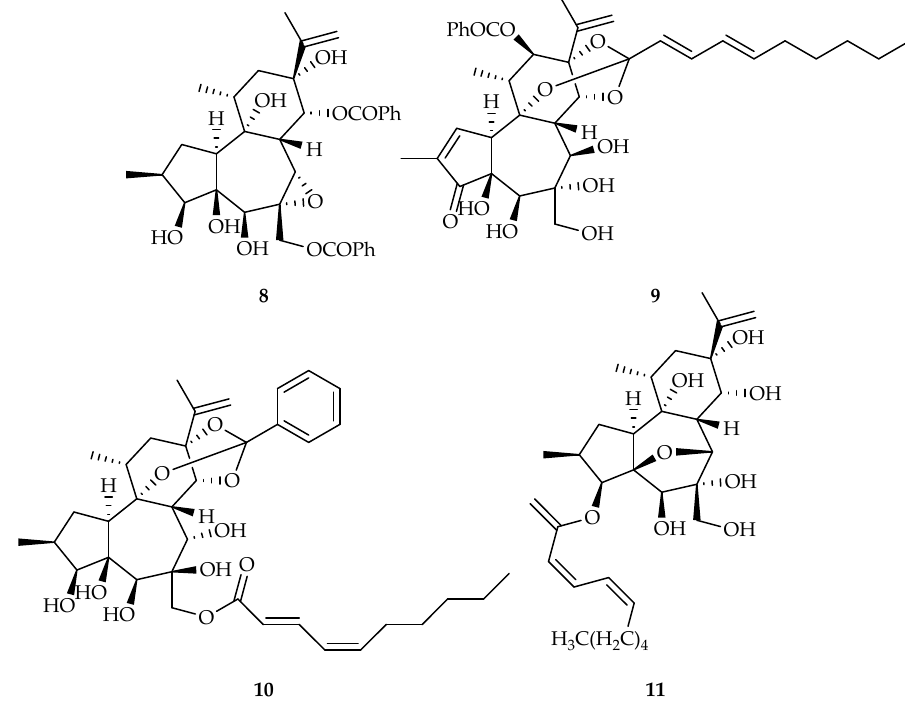
Figure 5. Structures of yuanhuakines A–D 8 – 11 [11]. A new daphnane with cytotoxic activity was isolated from the air-dried root of Euphorbia fischeriana Steud. By ethanolic extraction and subsequent partitioning with petroleum ether, CH 2 Cl 2 , EtOAc, and n -BuOH [12]. The new compound, named Langduin A 6 12 , showed IC 50 value of 13.42 μM against HepG2 (human hepatocellular liver carcinoma), using the CCK-8 assay and oxaliplatin as a positive control (Figure 6). From the dry roots of Euphorbia fischeriana Steud were also isolated two new daph- nane-type diterpenoids fischerianin A 13 and fischerianin B 14 [13]. Their structures, in- cluding the absolute stereochemistry, were determined by HRESIMS, IR, 1D and 2D NMR, as well as by comparing their experimental and calculated CD spectra. Compounds 13 and 14 harbor a ketal group and a 9,13-oxide bridge in their C ring, which is rare in daphnane-type diterpenoids. They showed cytotoxic activity against human cancer cell lines A375 (human melanoma cancer), HepG2, HL-60 (human erythroleukemia), K562, and HeLa, with IC 50 values ranging from 5.31 to 21.46 μM, using cisplatin as a positive control (Figure 6). Figure 6. Structures of Langduin A6 12 [12], fischerianin A 13 [13], and fischerianin B 14 [13]. 2.2.3. Fusicoccane-Type Diterpenoids Ten new fusicoccane diterpenes were isolated from the roots of Hypoestes forsskaolii (Vahl) R. Br. (Acanthaceae), a perennial bushy and leafy herb widely distributed in several